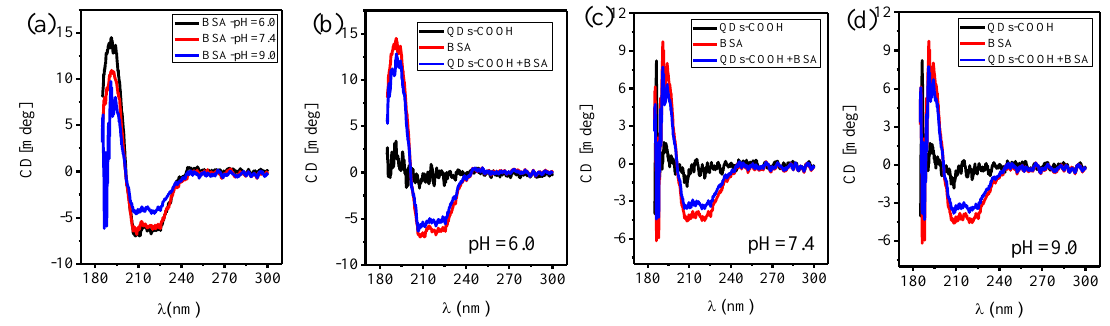
Figure 4. ( a ) Circula dichroism (CD) spectroscopy of bovine serum albumin (BSA) at different pH (6.0, 7.4, and 9.0); ( b – d ) CD of QDs-COOH, BSA, and a mixture of QDs-COOH (4 nM) and BSA (0.2 mM) at different pH (6.0, 7.4, and 9.0). In CD experiments, concentrations of QDs-COOH and BSA were 20 nM and 5 nM, respectively.